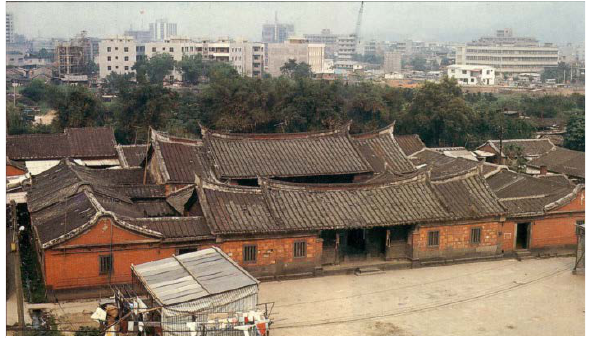
Figure 2: The Lin-An-Tai historic building in 1977 （ Gan-Lang Li,1977 ）